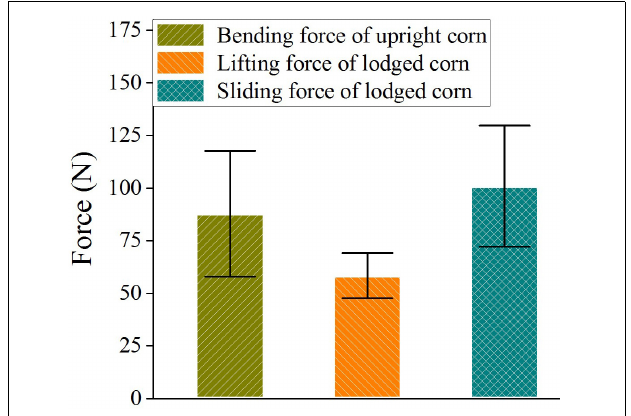
FIGURE 7 | Force-bearing capacities of upright and lodged corn stalks. Error bars indicate standard deviations.